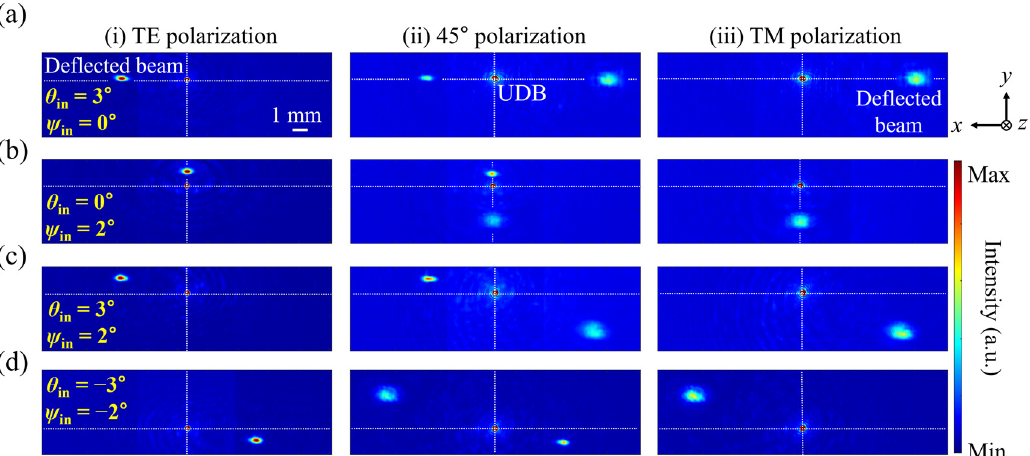
Figure5: Characterizationofpolarization-tailored2Dbeamsteering:Theincidentangles θ in and ψ in aresetat(a)3 ° and0 ° ,(b)0 ° and2 ° ,(c)3 ° and 2 ° , and (d) − 2 ° and − 3 ° along the horizontal ( x -axis) and vertical ( y -axis) directions, respectively. The fi gures in the left (i), middle (ii), and right (iii) columns represent the TE, 45 ° , and TM polarizations, respectively. Each captured image has dimensions of 19.2 mm × 5.12